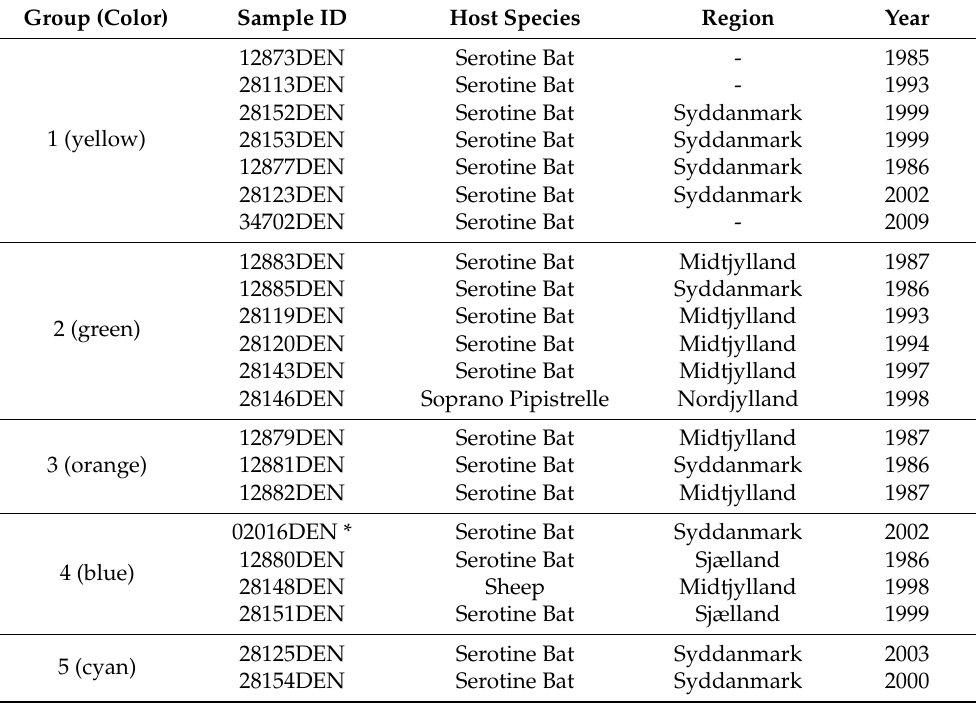
Table 2. Groups determined for the 21 Danish EBLV-1 full genomes and the isolate 02016DEN based on their phylogenetic